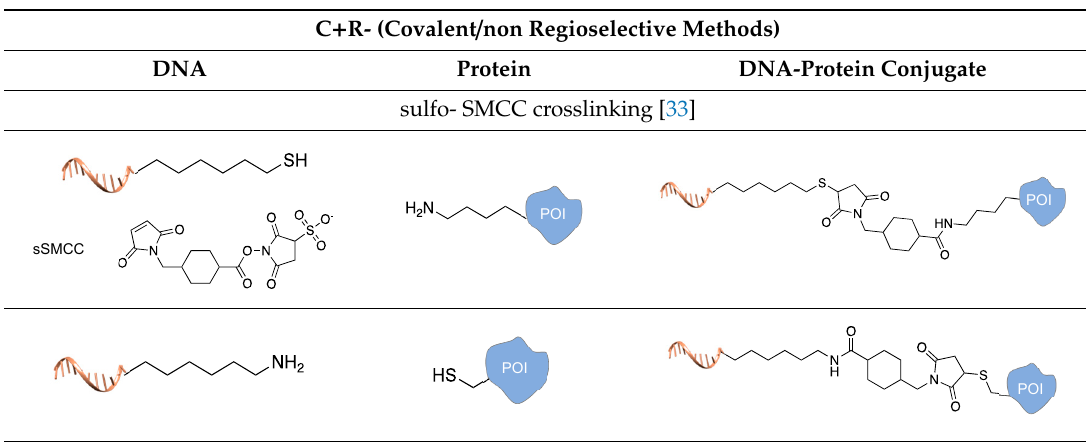
Table 1. Representative covalent and non-regioselective (C+R-) DNA-protein conjugation methods.